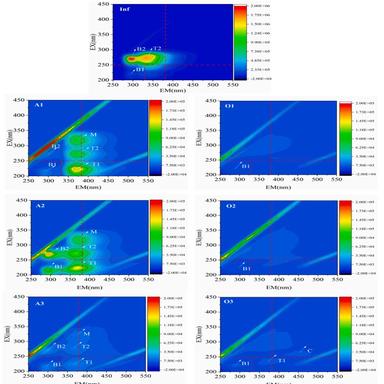
3D-EEM spectra in influent and effluent from different stages.